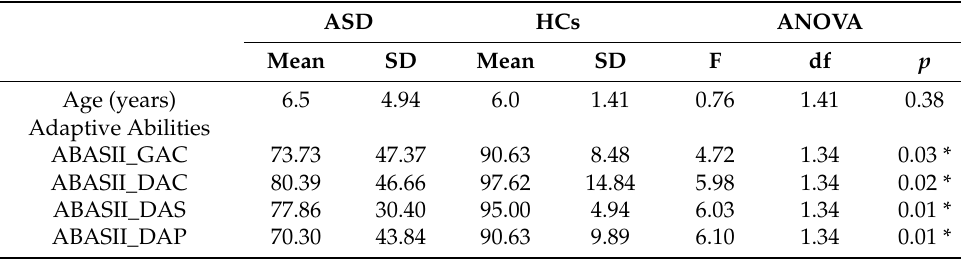
Table 5. Clinical standardised characteristics of the two children group (ASD and